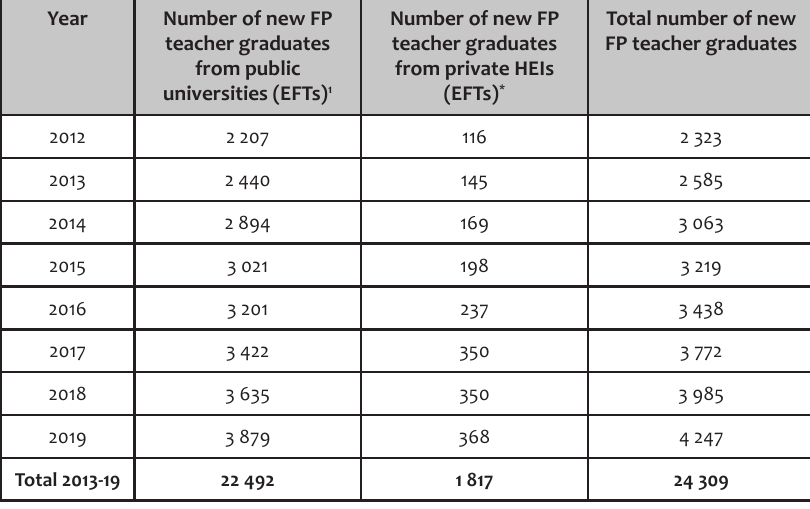
Table 3: New foundation phase teacher graduates,